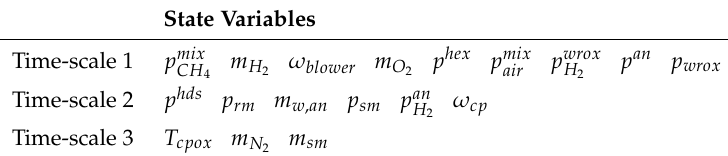
Table 3. State variable distribution among